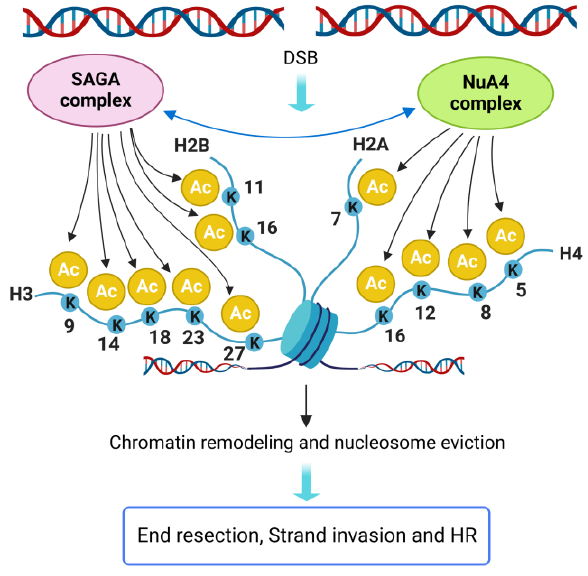
Figure 6. Histone acetylation promotes HR in S. cerevisiae . Multiple lysine residues of H2A and H4 histones are acetylated by the NuA4 complex, whose recruitment to the DSB ends is supported by the SAGA complex. SAGA, in turn, acetylates multiple H2B and H3 lysine residues. Histone acetylation causes extensive chromatin remodeling and nucleosome eviction, which promotes both DNA end resection and strand invasion. Double arrowheads line represents protein molecular interaction.